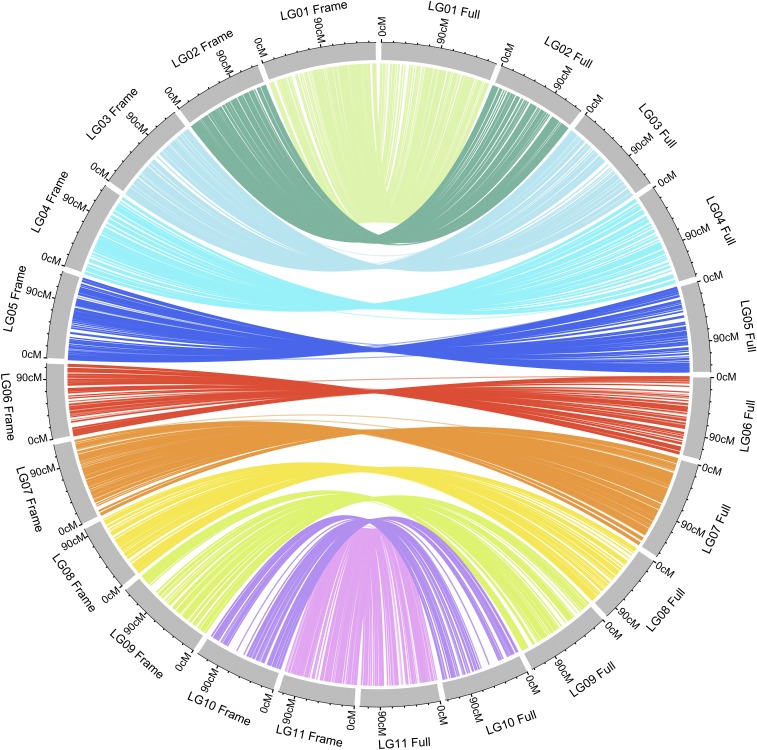
Synteny between the framework marker map and the full-set marker map. Lines connect the same marker on the two maps. Gray blocks on the left represent the 11 linkage groups of the framework map, whereas the 11 blocks on the right represent the full-set marker map.